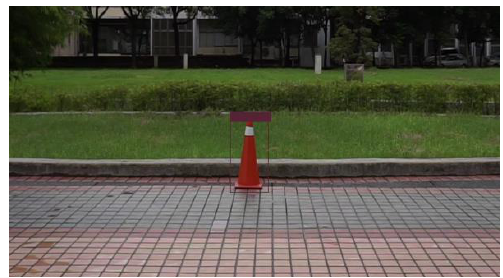
Figure 10. Parts of the Python Script of the Proposed